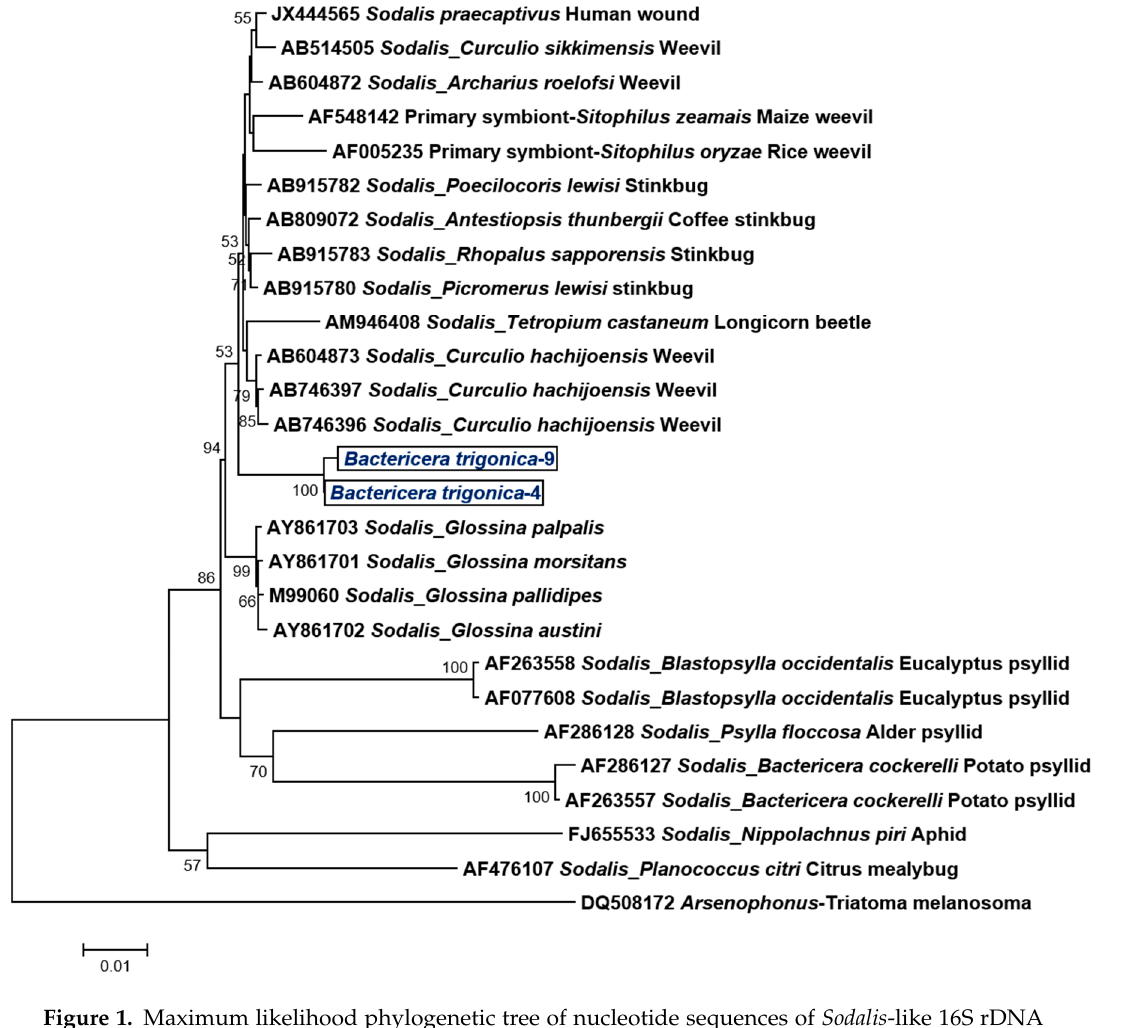
Figure 1. Maximum likelihood phylogenetic tree of nucleotide sequences of Sodalis -like 16S rDNA (1440 bp) from diverse insects by HKY + G + I nucleotide substitution model using MEGA 6. The Sodalis members identified inside B. trigonica are indicated inside a text box.